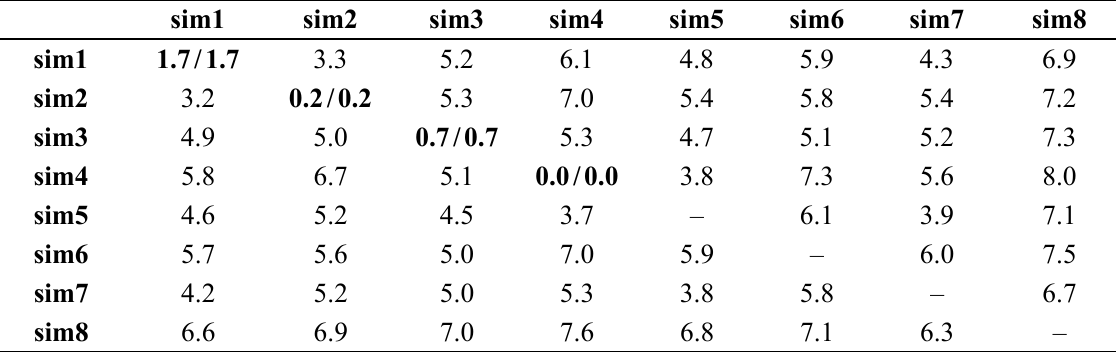
Table 1. Uncorrected (lower diagonal) and corrected (Jukes-Cantor model; upper diagonal) pairwise genetic distances of a fragment from COI mtDNA gene among the lineages of the Adenomera simonstuarti species complex (named as sim1–8). Within-lineage distances (uncorrected / corrected), when applicable, were highlighted in bold across the central diagonal (upper left to lower right). The lineage 3 corresponds to the nominal species. Values are presented as means (in